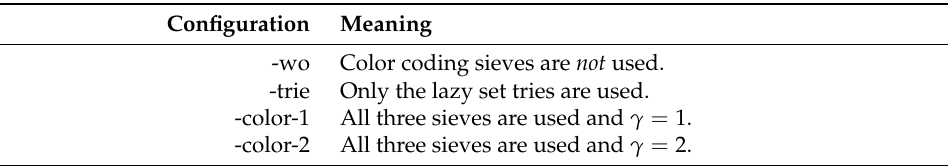
Table 2. Four configurations of PID (cid:63) used in the experiment. Configuration Meaning -wo Color coding sieves are not used. -trie Only the lazy set tries are used. -color-1 All three sieves are used and γ = 1. -color-2 All three sieves are used and γ =